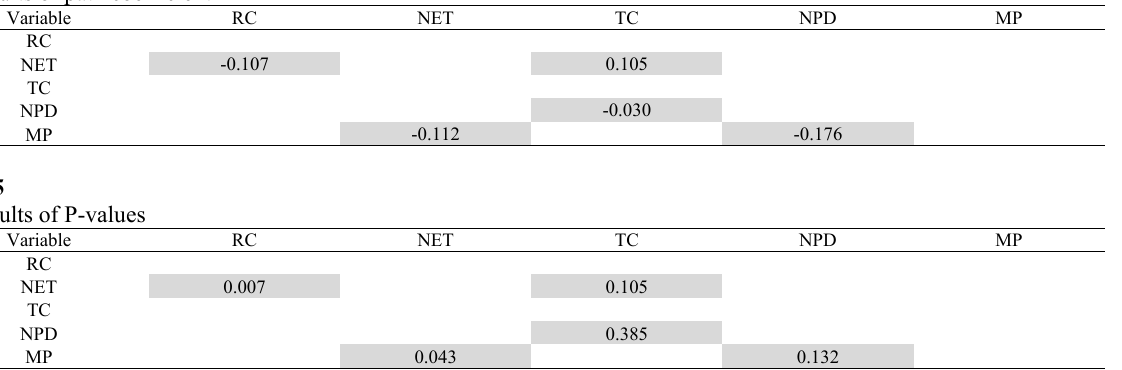
The results of path coefficient